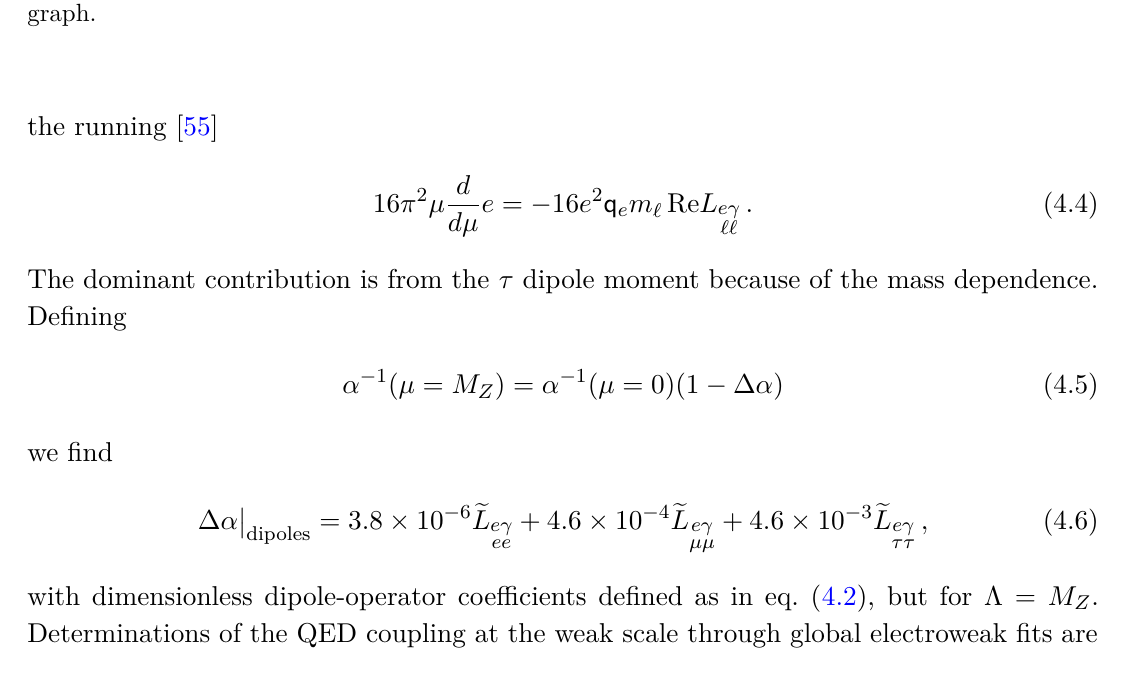
Figure 5 . Mixing between dipole operators and the QED charge through the vacuum polarization